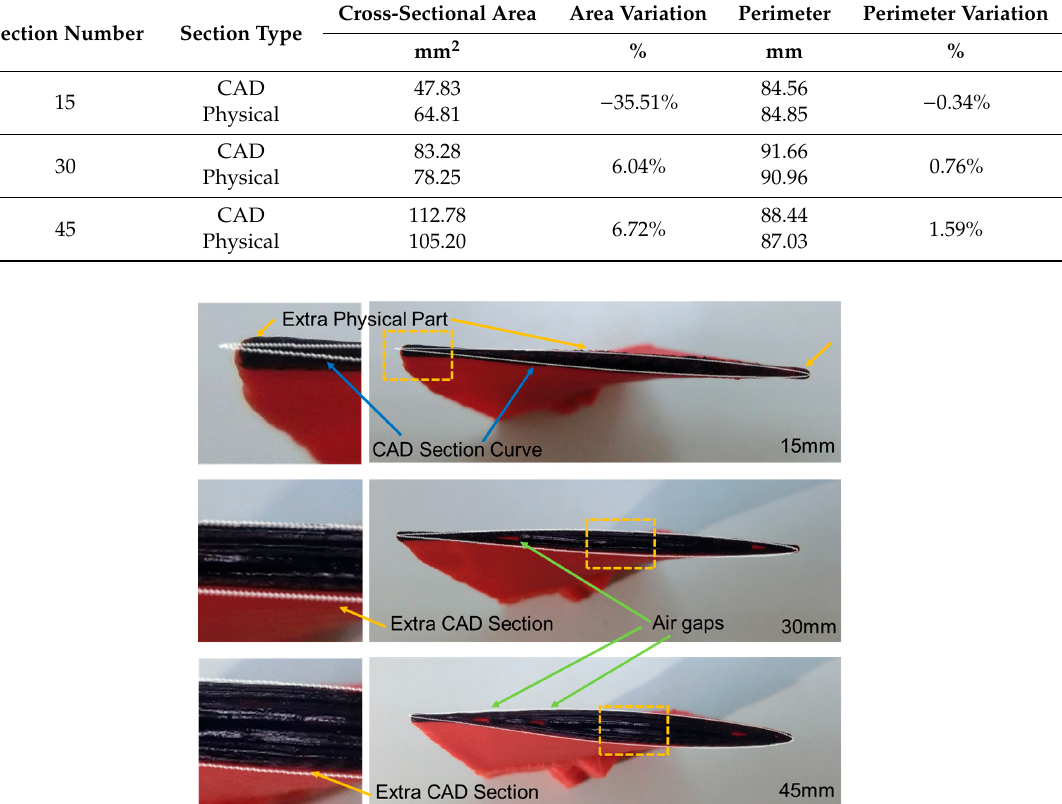
Figure 7. Manufactured truncated models and reference from the CAD model. The arrows show the quality of side edges of the 3D printed impellers. Table 2. The measurements values of CAD and physical models. Table 2. The measurements values of CAD and physical models.